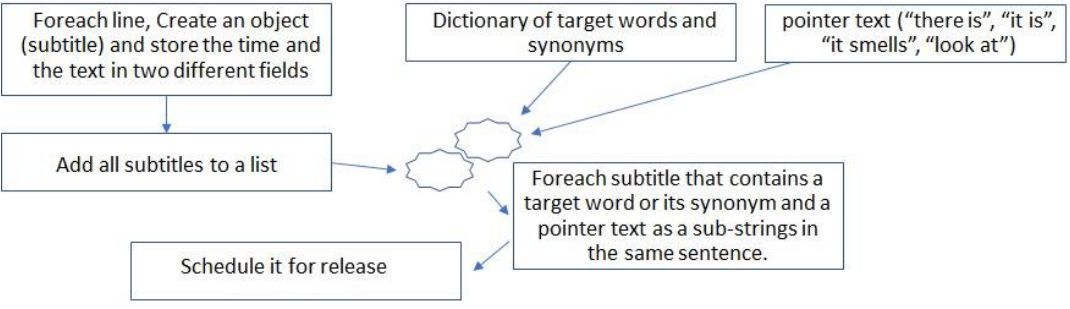
Figure 6. Releasing scents from subtitles.